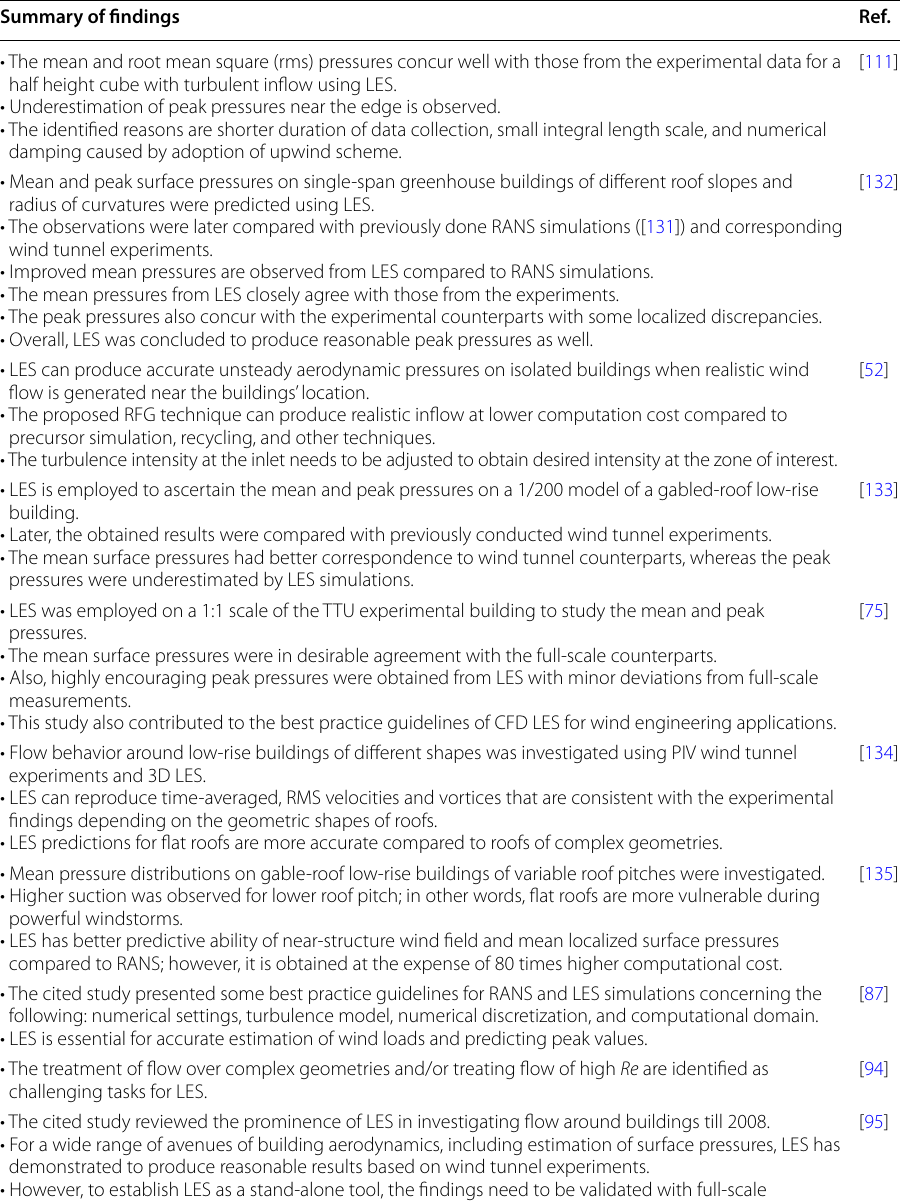
Table 3 Findings concerning LES in the literature for low-rise buildings Summary of